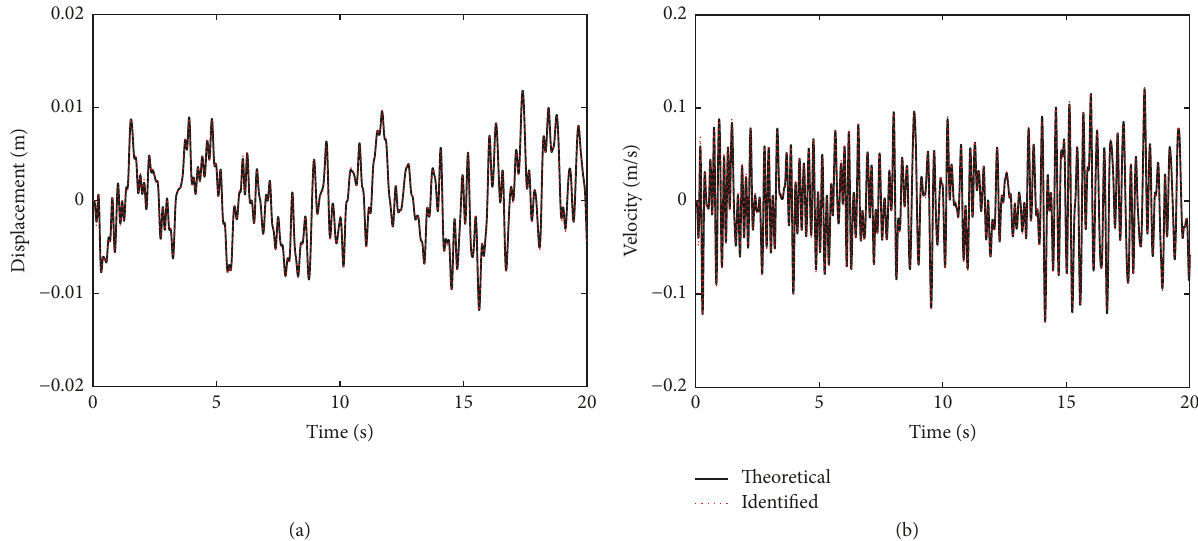
Figure 8: (a) The theoretical and identified vertical displacement at Node 7 by data fusion. (b) The theoretical and identified vertical velocity at Node 7.